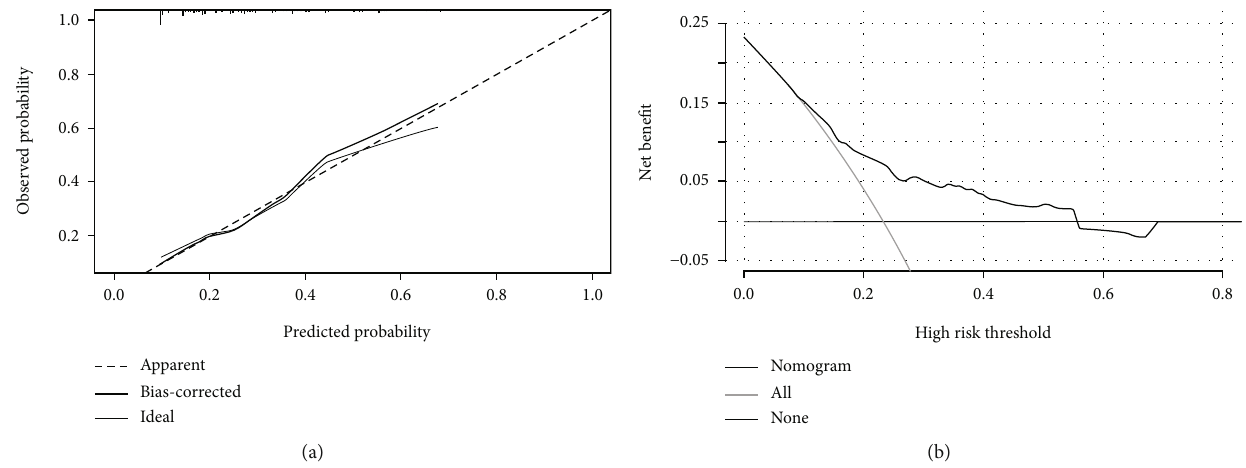
Figure 3: Evaluation of the nomogram. (a) Calibration plot of the nomogram for VTE in lung cancer (bootstrap 1000 repetitions). (b) Decision curve analysis (DCA) of the nomogram for VTE in lung